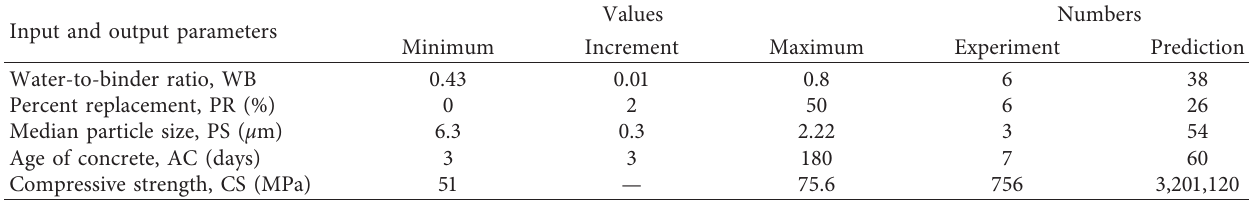
Table 5: Range values and numerable parameters of experiment and